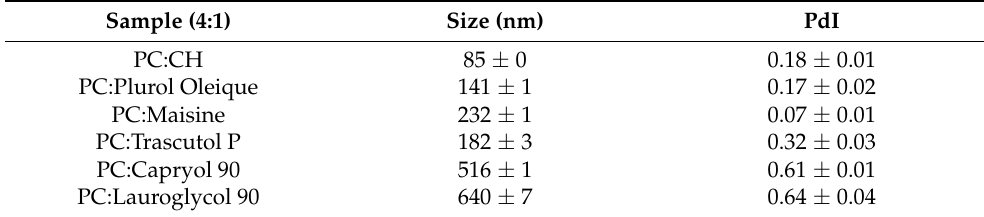
Table 1. Physical characterization of different liposomal formulations (Mean ± SD, n = 3). PC: phosphatidylcholine, CH: Cholesterol.